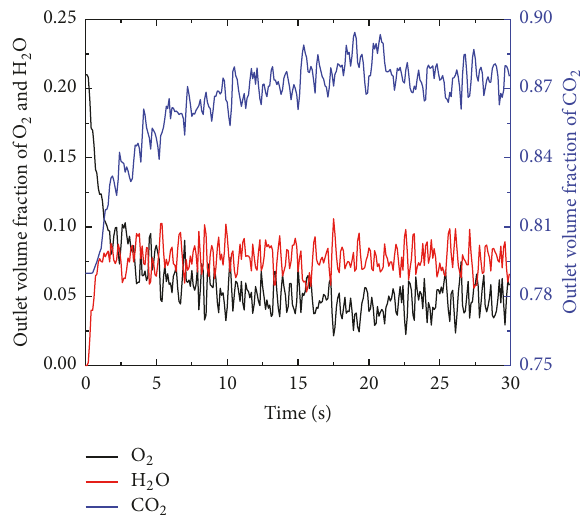
Figure 2: The gas (CO 2 , O 2 , and H 2 O) volume fractions along with time at the outlet.